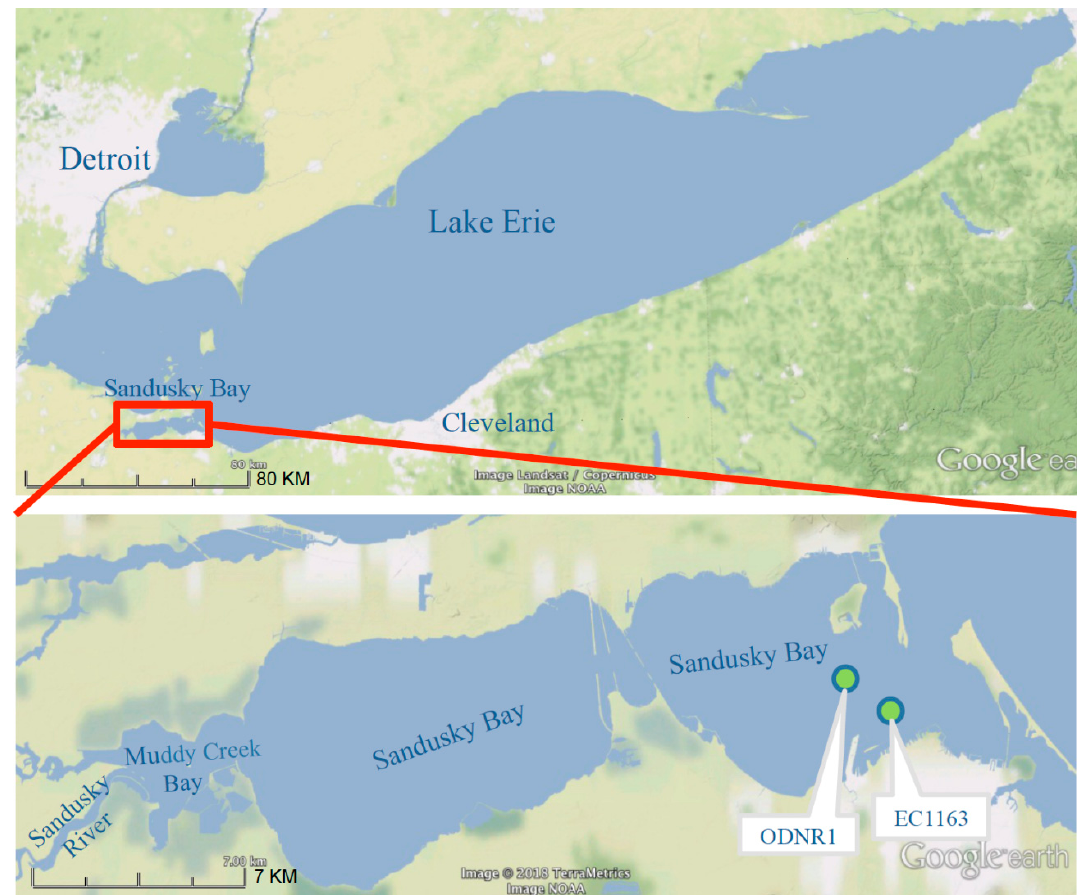
Figure 1. Sandusky Bay is situated on Lake Erie’s south-west coast occupying a small portion of the Great Lake’s coastline. Sandusky Bay is relatively shallow bay with an average depth of ~2.6 m. The primary draining watershed to Sandusky Bay originates from the Sandusky River on the west end of the bay. Sampling stations ODNR1 and EC1163 are denoted with green dots.